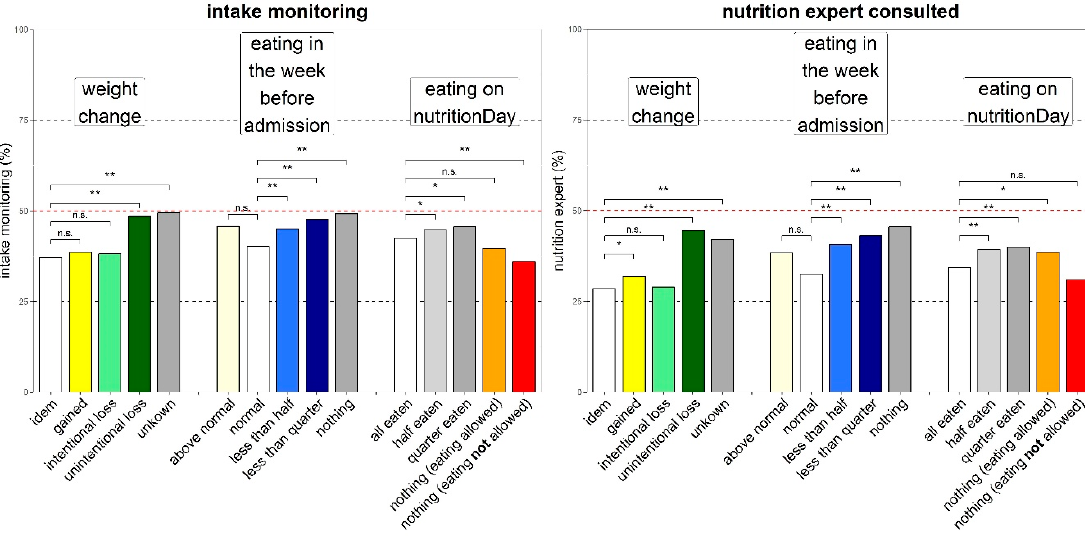
Figure 3. Nutrition care process indicators versus three nutrition associated risk factors. Daily nutrition intake monitoring (left) and nutrition expert consulted (right). Bars indicate percentage answering “yes”, significant differences to each reference group are shown with * p < 0.005 and ** p < 0.00001, ‘n.s.’ indicates no significant difference. Missing values were <7.5% in all subcategories. Colour coding similar to Figure 1 (the empty bar is the reference).